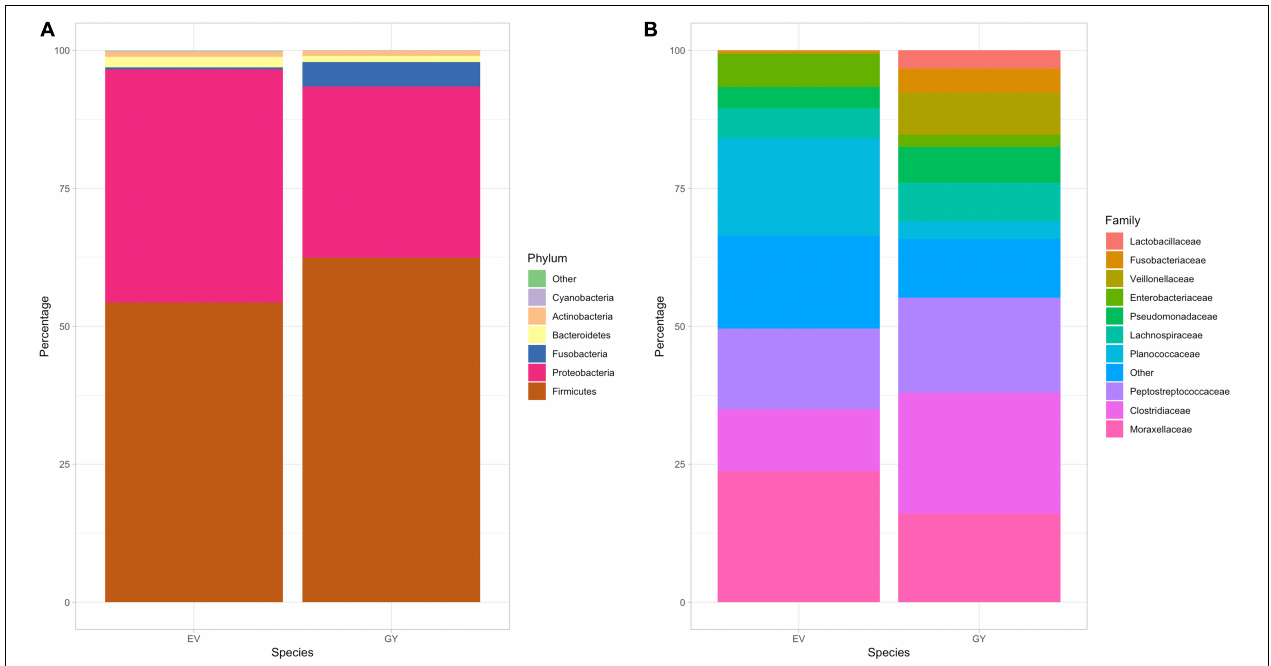
FIGURE 2 | Gut bacterial composition of Egyptian and Griffon vultures. Taxonomic bacterial profile of 52 fecal samples from Egyptian (EV; six individuals, n = 22 samples) and Griffon vultures (GY; seven individuals, n = 30 samples) at phylum ( A ; left) and family ( B ; right) level. Of 75 families classified, only 14 with an abundance > 1% of total reads are